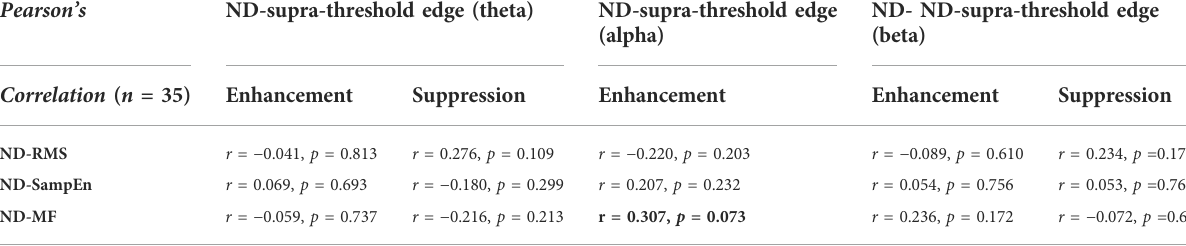
TABLE3Pearson ’ scorrelation betweenchangesinsupra-thresholdinter-regionalcouplingofspectralbands/key-nodesandstabilometerdynamics. Pearson ’ s correlation between changes in supra-threshold inter-regional functional coupling ( p < 0.005) of various spectral bands and postural sway dynamics due to stroboscopic vision. The numbers within parentheses are the edge number of each key node. The black-bolded and grey- bolded fonts in the shaded areas indicate signi fi cant and marginally-signi fi cant correlations of regional activity and postural sway dynamics, respectively.